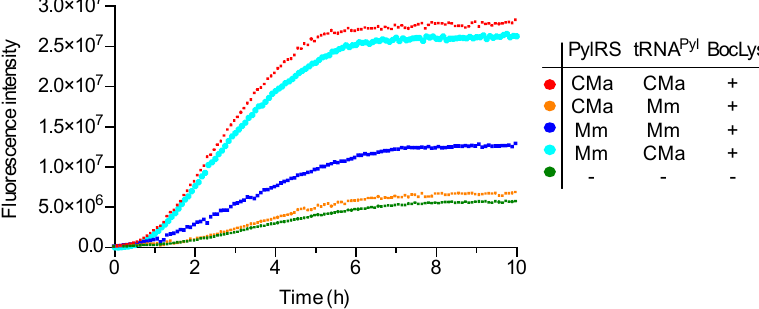
Figure 3. Cell-free UAG translation. The fluorescence intensity of the reaction mixture containing the indicated pair of PylRS and tRNA Pyl was measured at 485 nm with five-minute